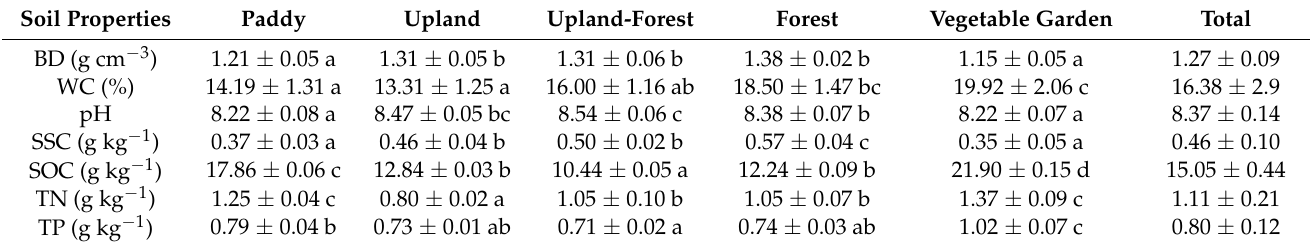
Table 2. The determined topsoil properties (mean ± S.D.) under different land-use types ( n = 5 for each land-use type, n = 25 for total, different letters mean significant difference